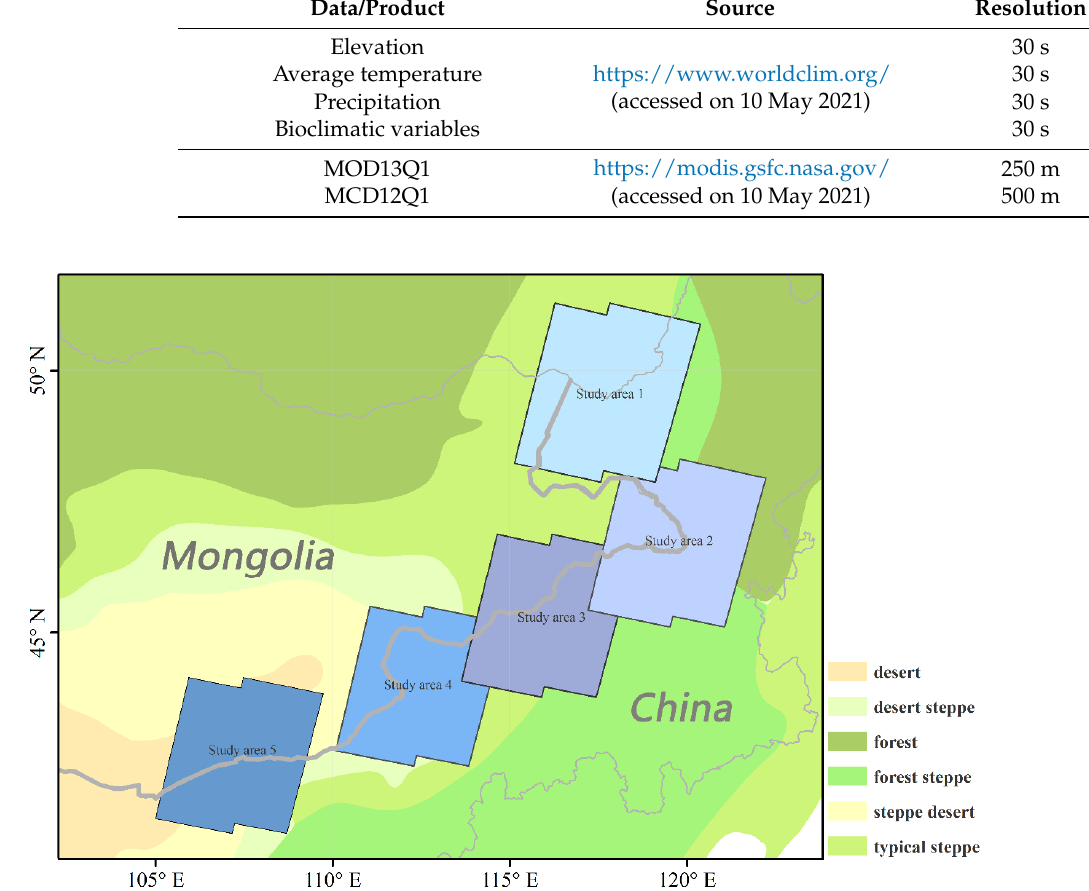
Figure 1. Location of the study area.